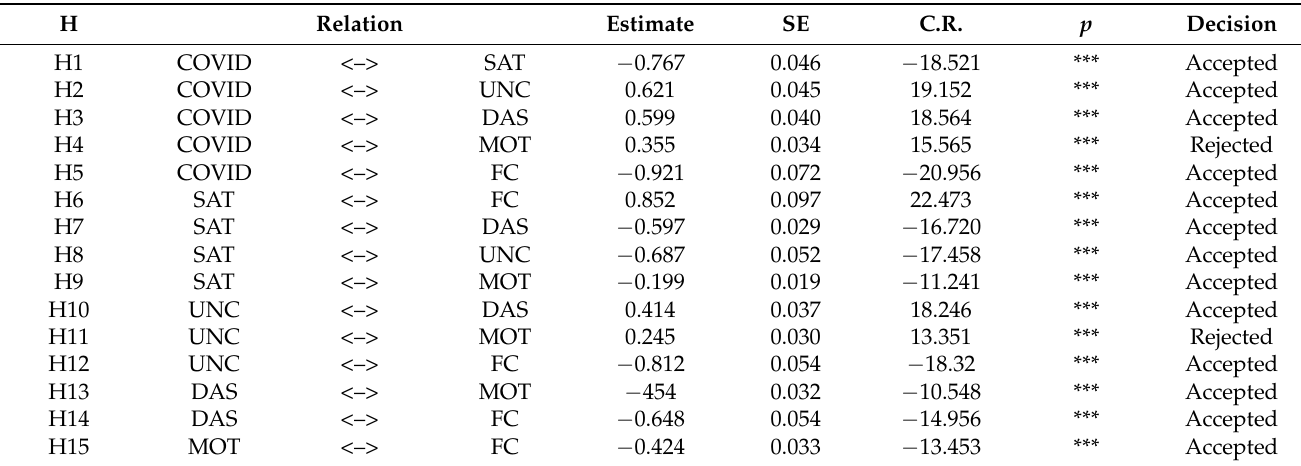
Table 3. Covariance relationships between the